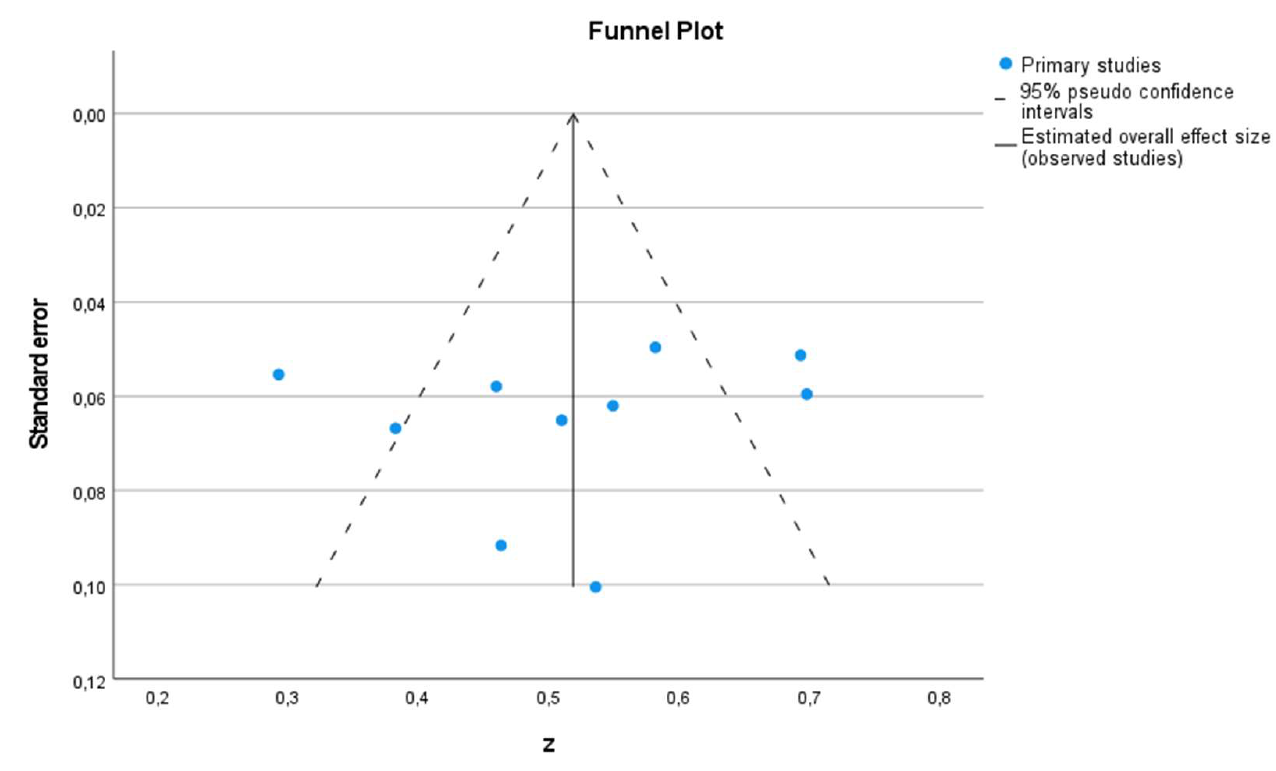
Figure 15. Forest Plot for Correlation Data.